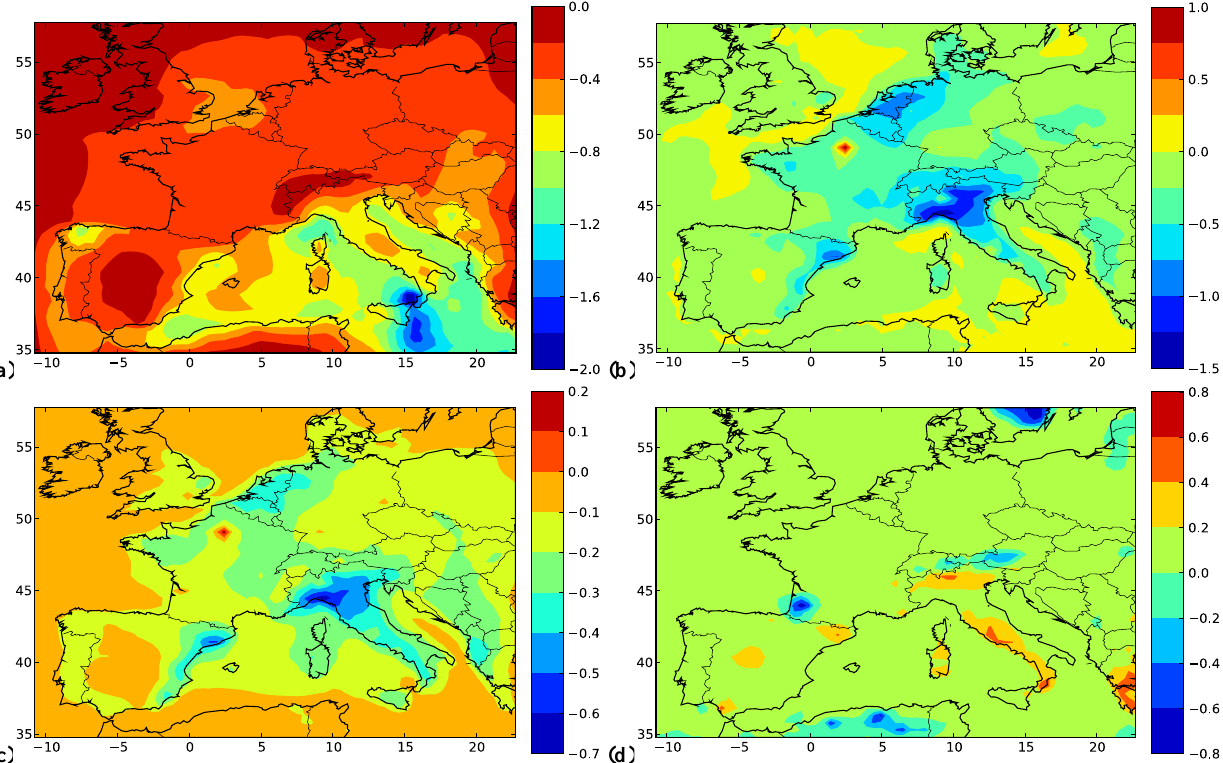
Fig. 6. Differences (CB05 – RACM2,µgm − 3 ) of PM 2 . 5 chemical components over Europe: (a) sulfate, (b) nitrate, (c) ammonium, (d) SOA.